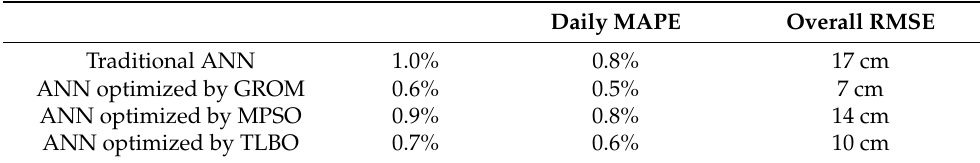
Table 8. The MAPE scores the traditional ANN model and ANN forecast model optimized by GROM. Daily MAPE Overall RMSE Traditional